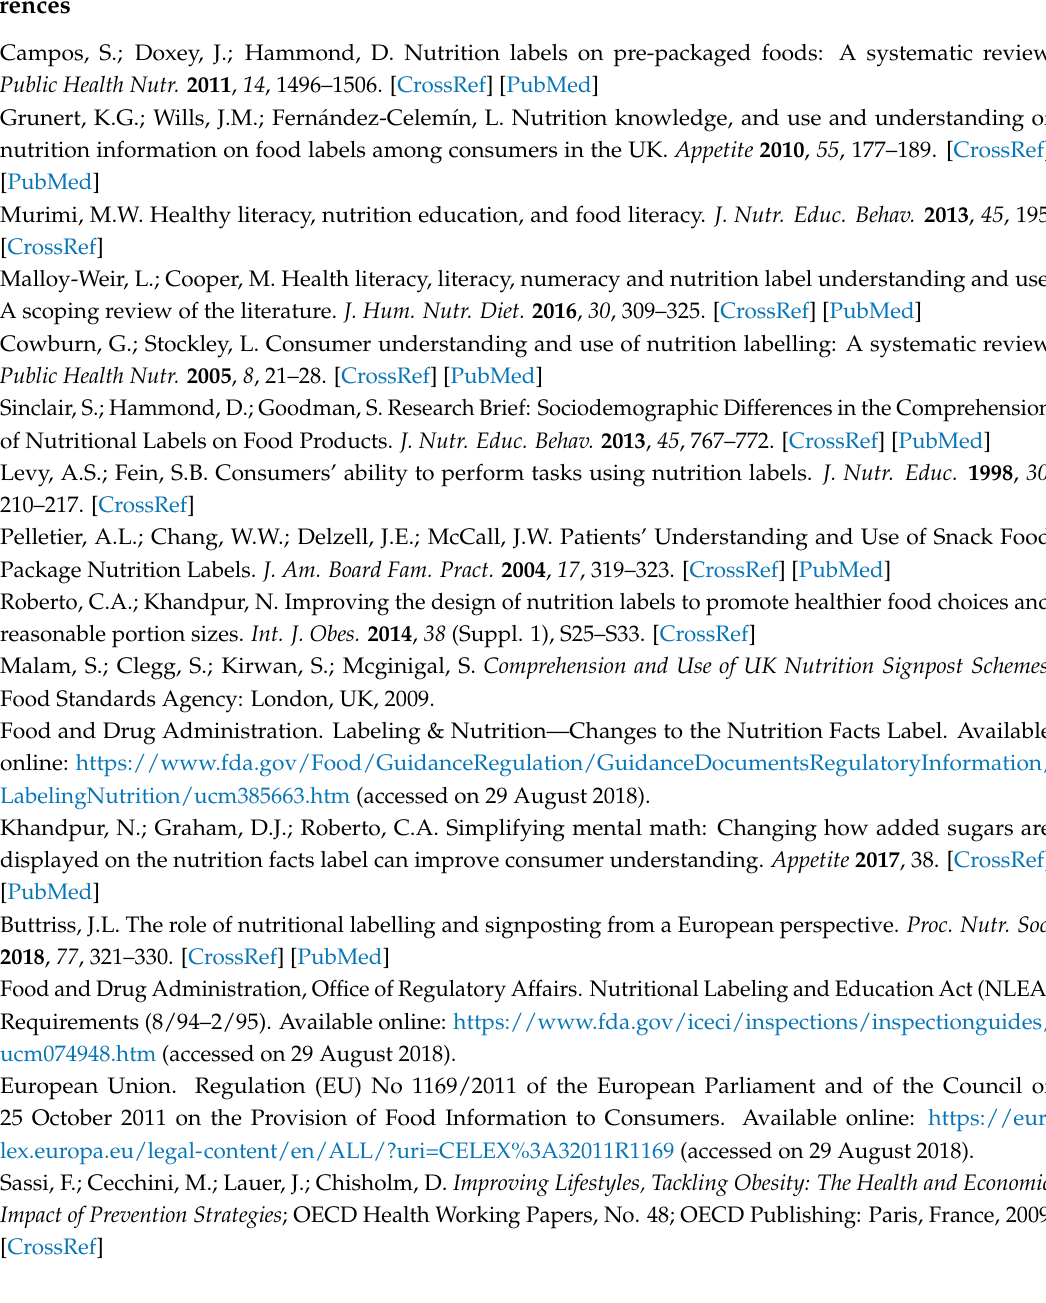
s1. Table S1: Search terms and strategy for the Medline database. Table S2: Quality appraisal of individual studies using Effective Public Health Practice Project (EPHPP) Criteria. S1: PRISMA 2009